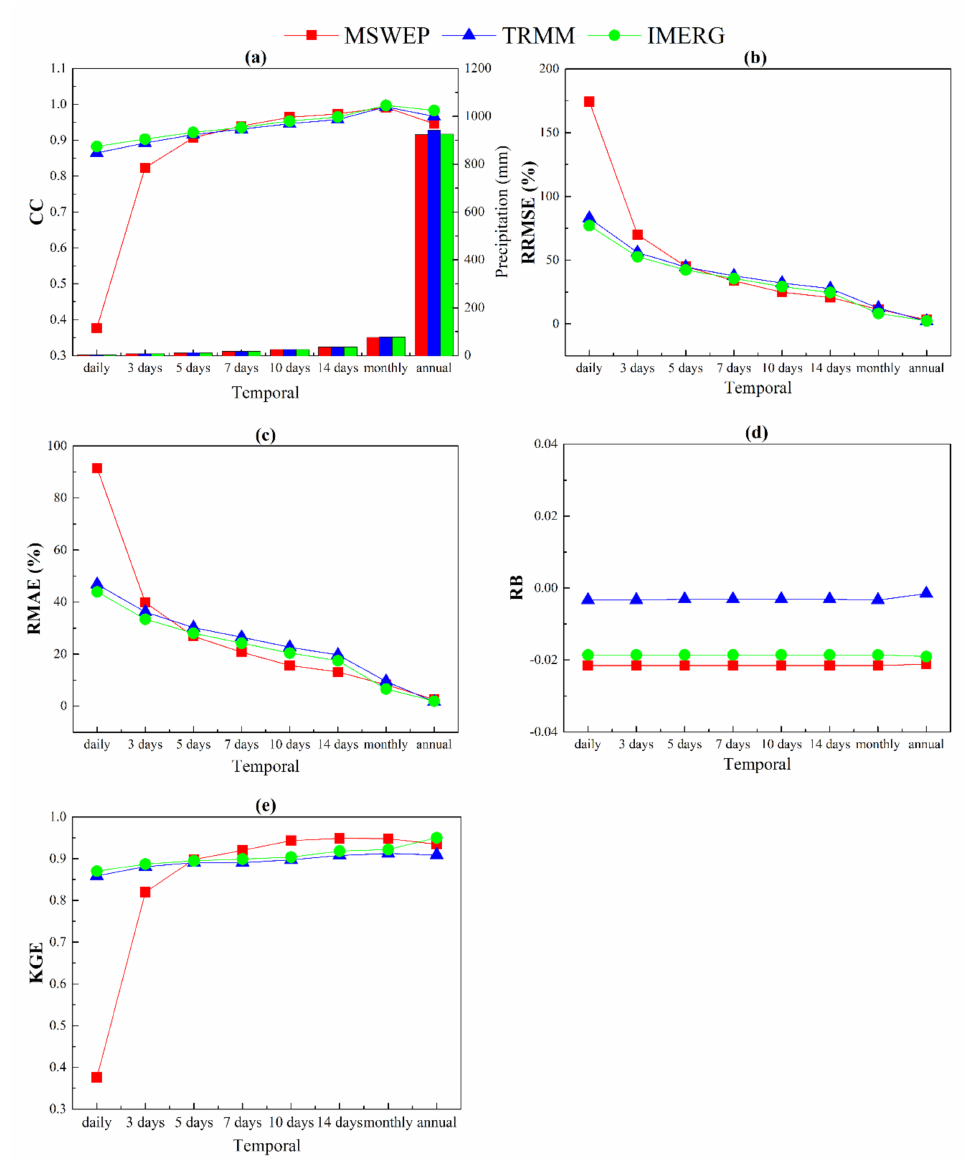
Figure 3. Distribution of continuous statistical metrics (( a ) CC , ( b ) RRMSE , ( c ) RMAE , ( d ) RB , and ( e ) modified KGE ) of the comparisons between the three precipitation products and ground observa- tions at different temporal resolutions. The histogram in ( a ) represents the average precipitation at different temporal resolutions for each precipitation product at the basin average